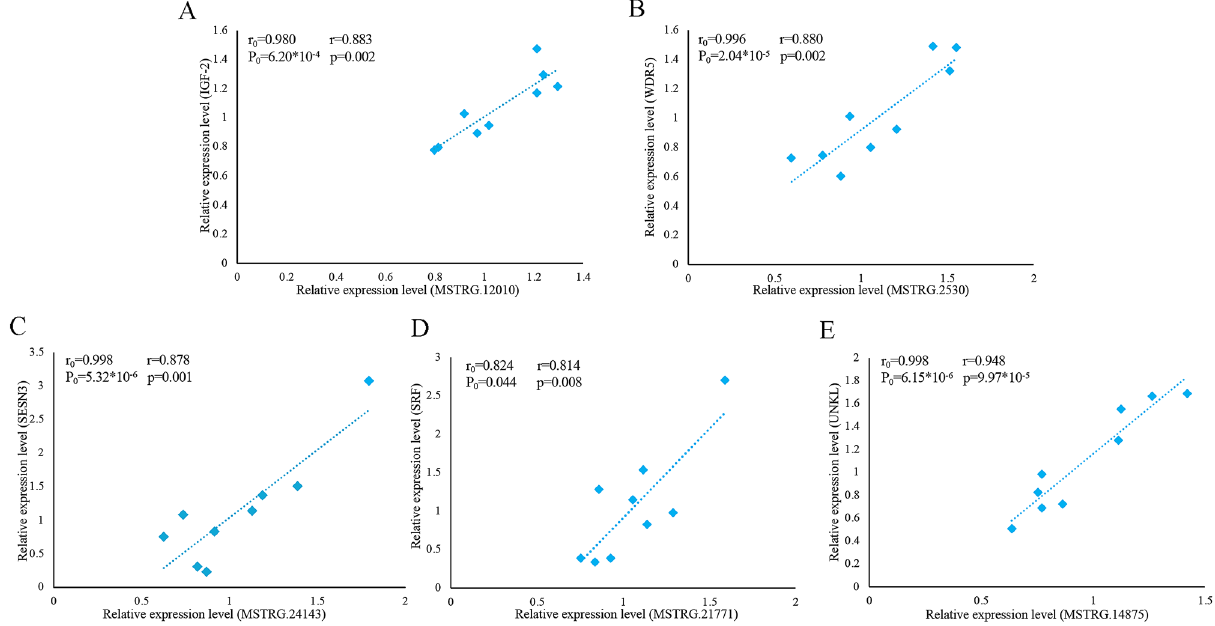
Figure 7. Linear regression of lincRNA and PTG expression. The r 0 and p 0 represent the Pearson correlation coefficient and p value of each pair of lincRNA and PTG in 6 samples, respectively; The r and p represent verification in 9 samples. ( A ) MSTRG.12010 vs IGF-2. ( B ) MSTRG.2530 vs WDR5. ( C ) MSTRG.24143 vs SESN3. ( D ) MSTRG.21771 vs SRF. ( E ) MSTRG.14875 vs